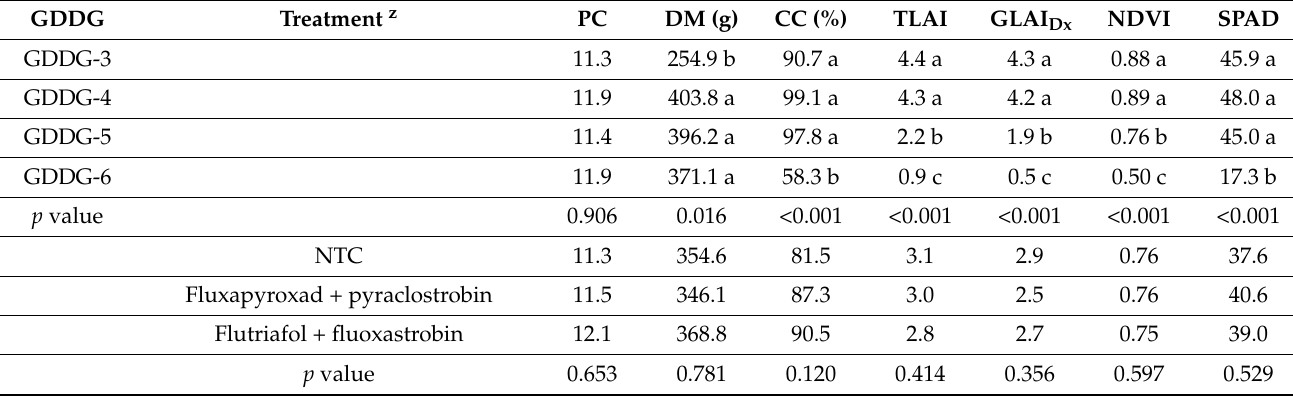
Table 6. Least square means y of the plant count (PC), dry matter (DM), canopy cover (CC), total leaf area index (TLAI), green leaf area index with disease severity removed, normalized difference vegetation index (NDVI), and soil plant analysis development (SPAD) readings for different growing degree date groups (GDDG) and treatments recorded in a field experiment conducted in Lewis